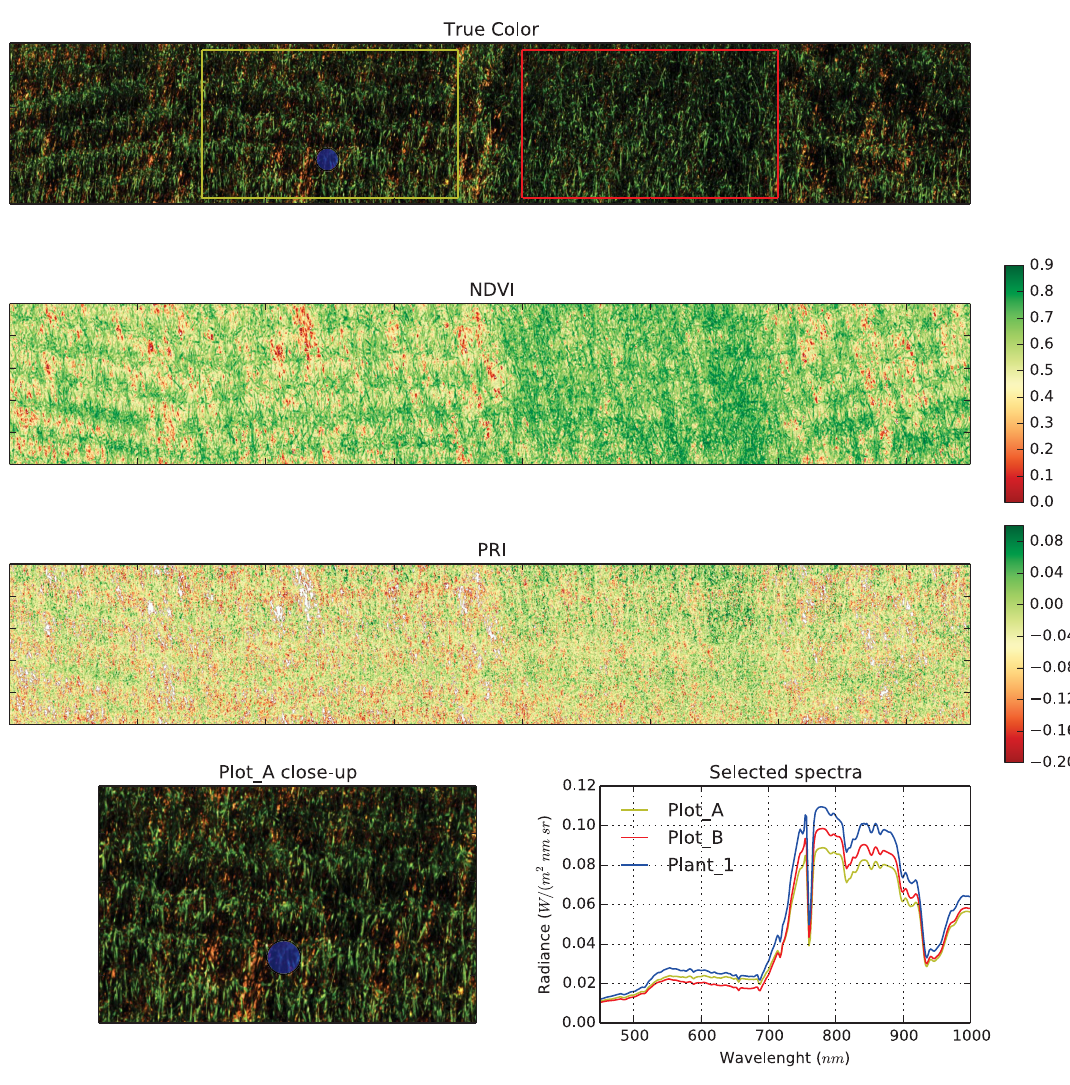
Figure 9. Hyperspectral image of wheat with the camera mounted on Phenomobile. From top to bottom: a true color composite showing the selection of two plots differing for plant density (Plot_A in yellow, lower plant density, and Plot_B in red, higher plant density) and a single plant (Plant_1 in a blue circle); an NDVI image from the same hyperspectral image; a PRI image; a close-up look at Plot_A; plots of spectral radiance of Plot_A, Plot_B and